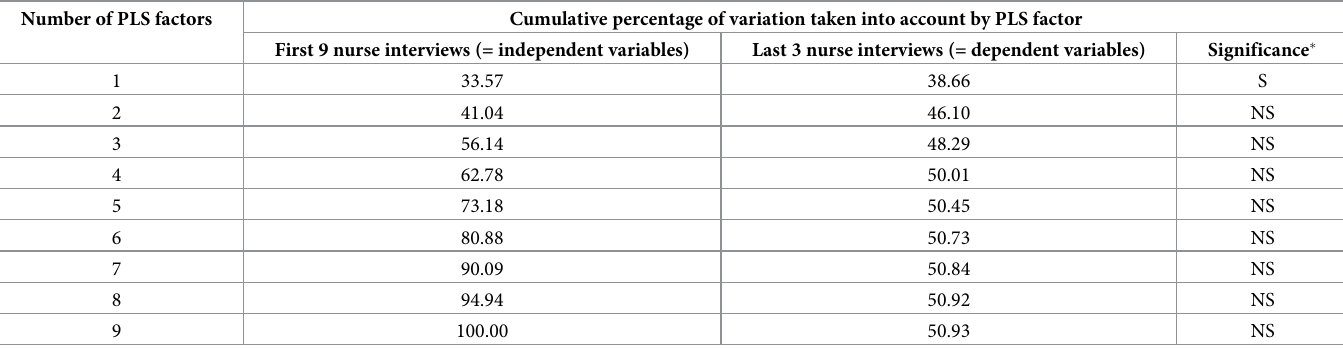
Table 1. Cumulative percentage of variation of the first nine nurse interviews and the last three nurse interviews taken into account by PLS factor (N =